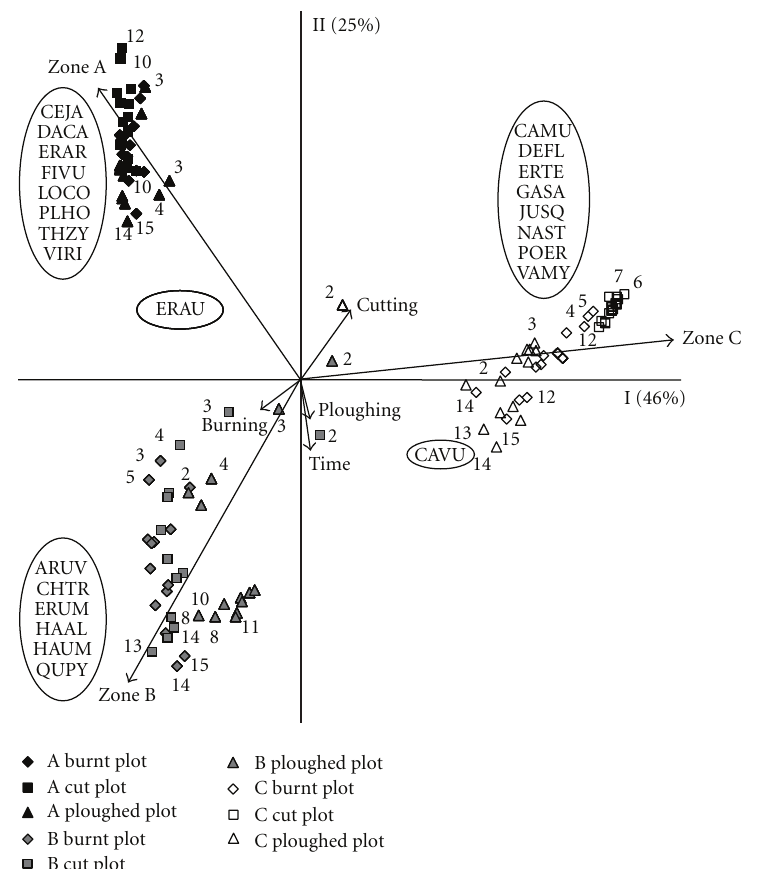
Figure 4: Canonical Correspondence Analysis (CCA) for plant species composition and environment variables (zones, experimental treatments, and time). Variance explained: 46% axis I, 25% axis II; Monte Carlo permutation test: F = 35.61; P = 0 . 002. Environmental variables abbreviations are: zone A (dashed shape), zone B (grey shape), zone C (empty shape); burning: diamond; cutting: square; ploughing: triangle; time: numbers representing years after experimental disturbances. Arrows mark the environmental coordinates. Name of species: CAMU: Carex muricata ; DEFL: Deschampsia flexuosa ; ERTE: Erica tetralix ; GASA: Galium saxatile ; JUSQ: Juncus squarrosus